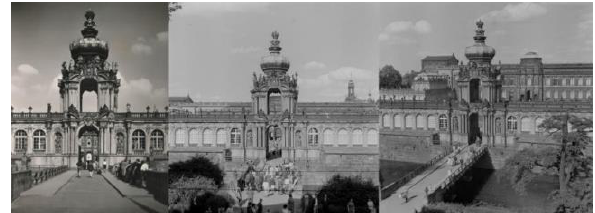
Figure 2. Examples for historical images of the Kronentor used for